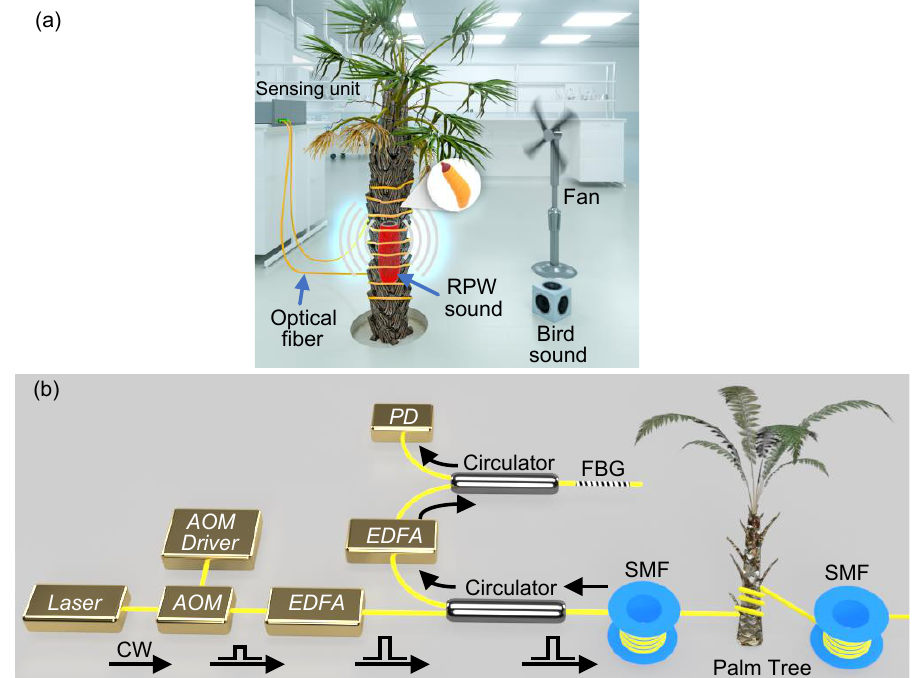
Figure 2. ( a ) Overall design of using the fiber optic distributed acoustic sensor (DAS) to detect the RPW sound. ( b ) Experimental setup of the DAS interrogation